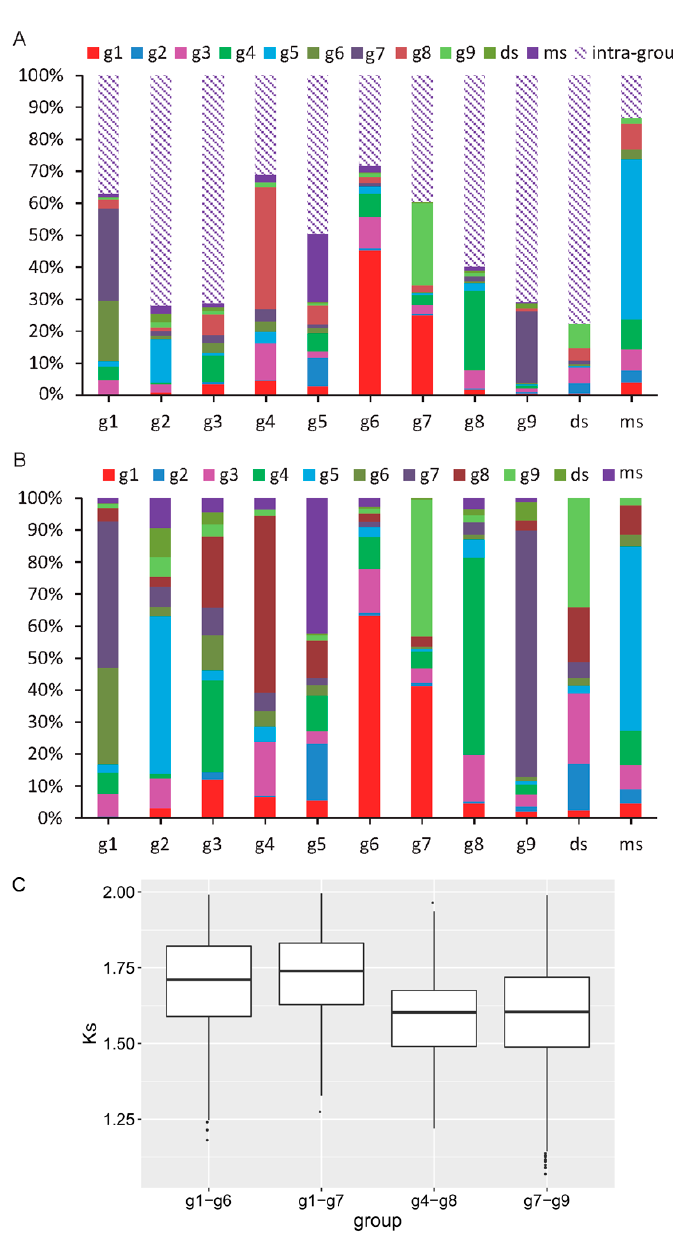
Figure 4. The synteny relations between groups and the Ks value of three pairs of groups. ( A ) A percentage stacked bar chart of all inter-group and intra- group synteny relationships. ( B ) A percentage stacked bar chart of all inter-group synteny relationships. ( C ) The Ks value of four pairs of groups with a relatively high number of synteny relationships.